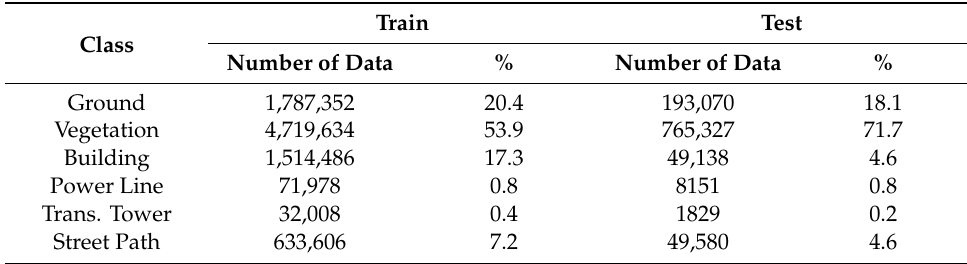
Table 1. Number of points for the training data and test